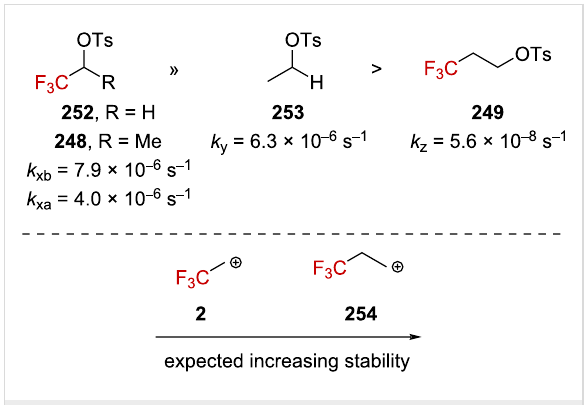
Figure 11: Solvolysis rate of 248 , 249 , 252 , and 253 in 91% H 2 SO 4 .